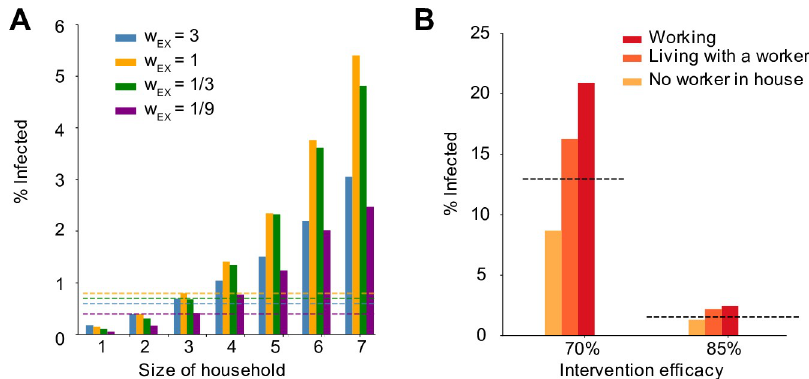
Fig 6. Individual risk of infection depends on household size and worker status. A) Risk of infection versus household size in simulations. Risk of infection was calculated after 300 days, with 100% intervention efficacy. Bar colors represent different relative weights of external contacts (compared to household contacts). Dotted lines are the population level average infection levels for the same scenarios. B) Risk of infection versus worker status. A “worker” is defined as someone with an occupation in which they continue to work outside the home despite social distancing measures. Categories include being a worker yourself (red), living in a household with at least one other individual who is working (orange), or having no workers in the house (yellow). As a comparison the population average risk is shown (dotted line). Interventions that reduce the overall number of people working outside the home by 70% and 85% are shown (in all cases all schools are assumed to be closed and the same percent of social and community contacts are removed).